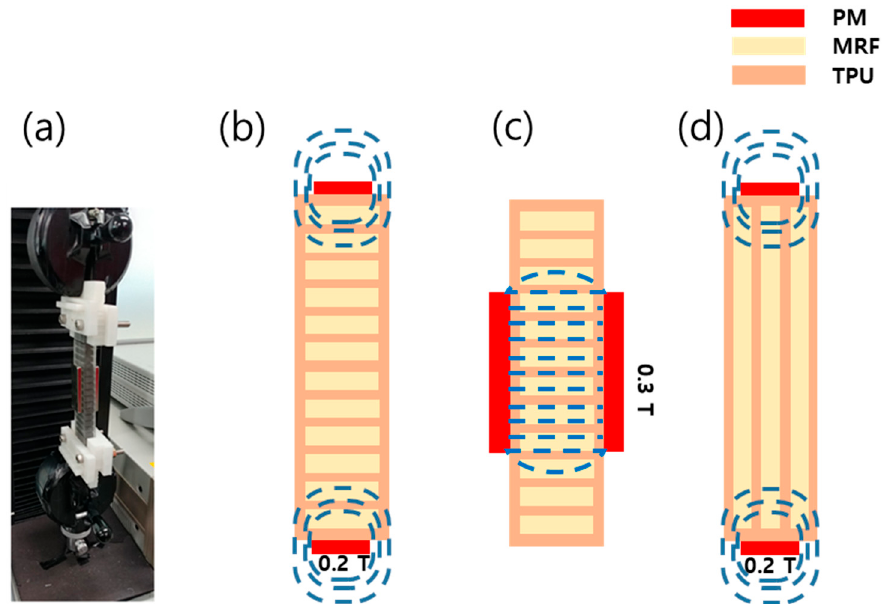
Figure 6. Magnetic field distribution patterns as a function of the permanent magnet (PM) configuration: ( a ) photograph and ( b ) top–bottom, ( c ) lateral (side), and ( d ) top–bottom (with a different cabin structure) configurations.